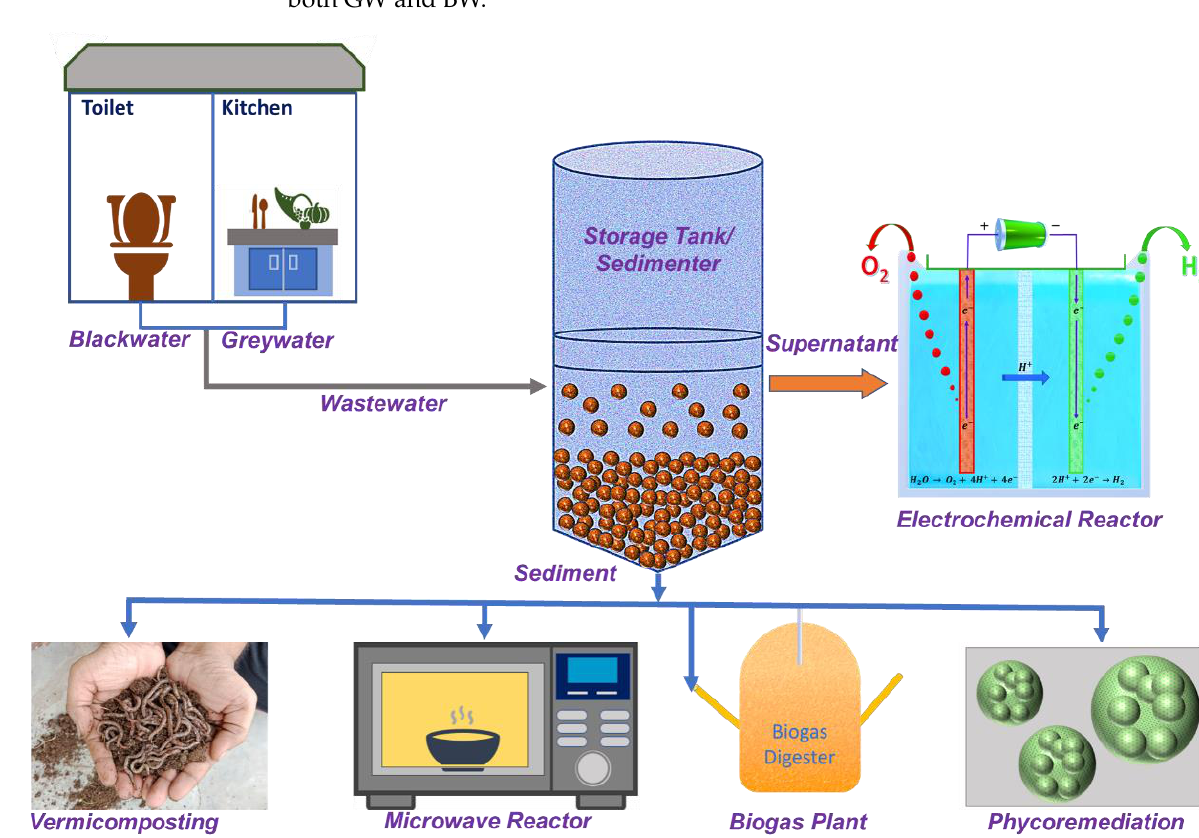
Figure 4. Diverse renewable methods proposed for the decentralized treatment of BW. These methods could also be applicable for the decentralized treatment of GW generated from rural areas.